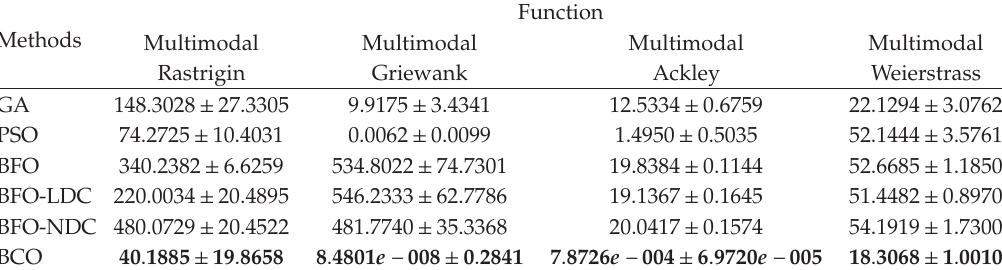
Table 6: Experimental results on multimodal benchmark functions f 5 ∼ f 8 (cid:3) 40-D (cid:4) . Methods